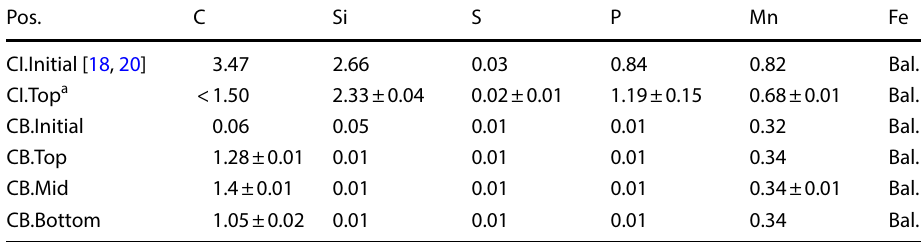
The chemical composition of the collector bar after usage in the cell was measured with OES a Measured with calibrated OES grey cast